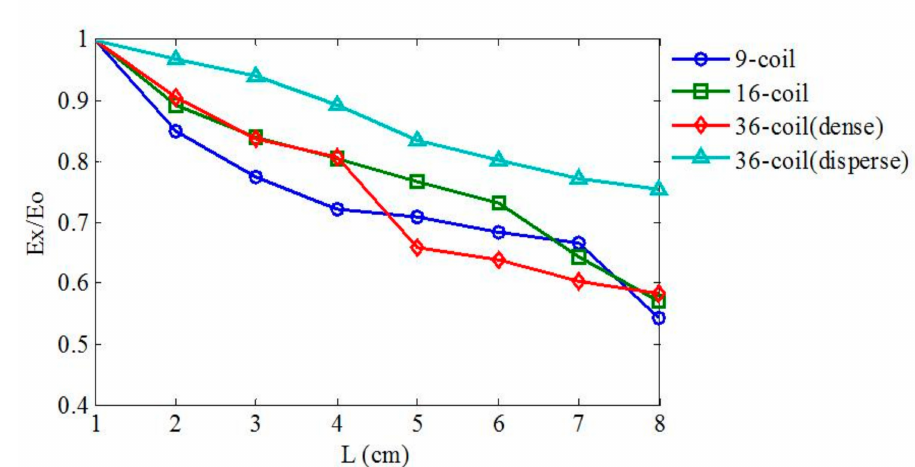
Figure 6. The variation tendency of EF intensity generated by multi-coil arrays of distinct